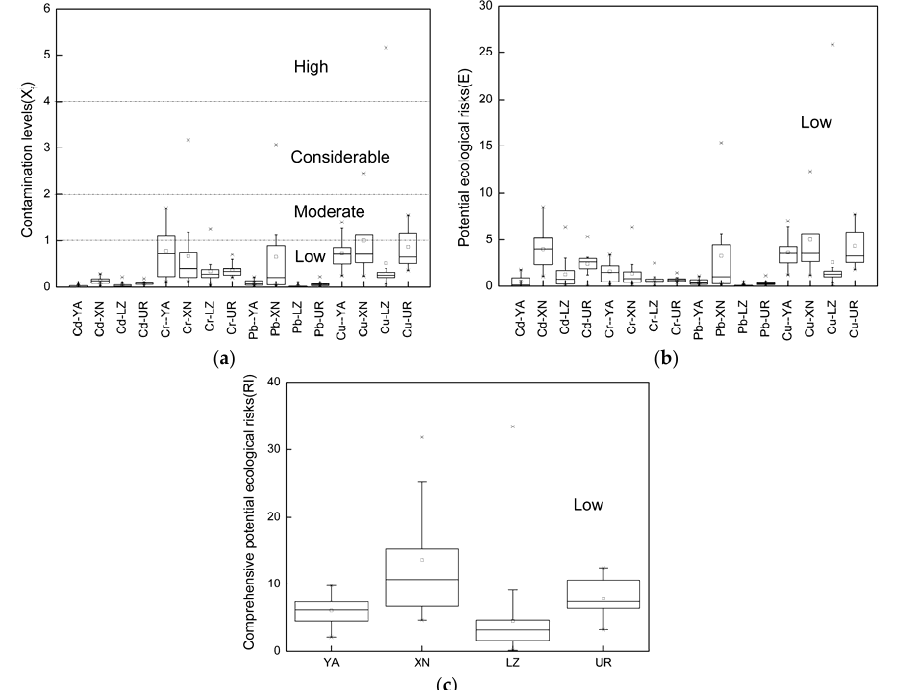
Figure 3. The contamination levels X i ( a ), potential ecological risk index (E) of HMs ( b ) and the comprehensive potential ecological risks (RI) ( c ) boxplots diagrams in the four city rivers. Note: The horizontal ordinate means: YA means Yan River in Yan’an city; XN means Huang River in Xining city; LZ means Yellow River in Lanzhou city; UR means Peaceful Canal in Urumqi city; Cd-YA stands for heavy metal Cd in Yan River in Yan’an city; Cd-XN for heavy metal Cd in Huang River in Xining city; the heavy metals-abbreviations of city river stands for this metal in the city river in different city, for example, Cd-LZ for heavy metal Cd in Yellow River in Lanzhou city; Cd-UR for Peaceful Canal in Urumqi city. And “*” means the